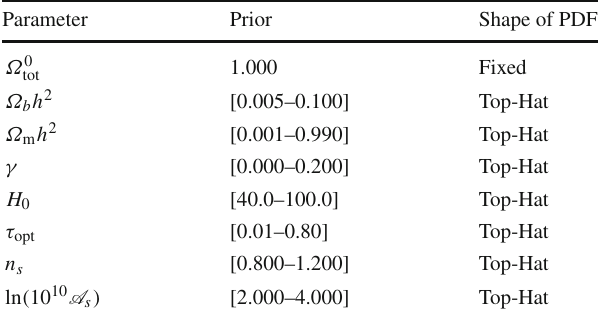
Table 2 Priors on parameter space, used in the posterior analysis in this paper